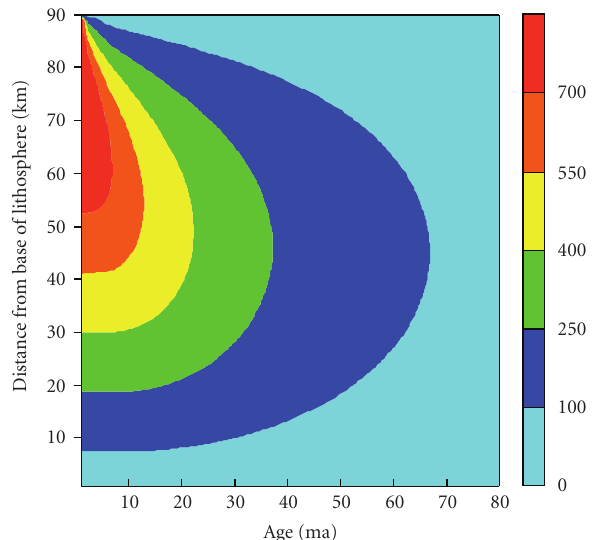
Figure 6: Vertical distribution of transient temperatures in the Plate model (McKenzie, [2]), for the parameter values listed in Table 1. The numbers on the curves are temperatures in degrees